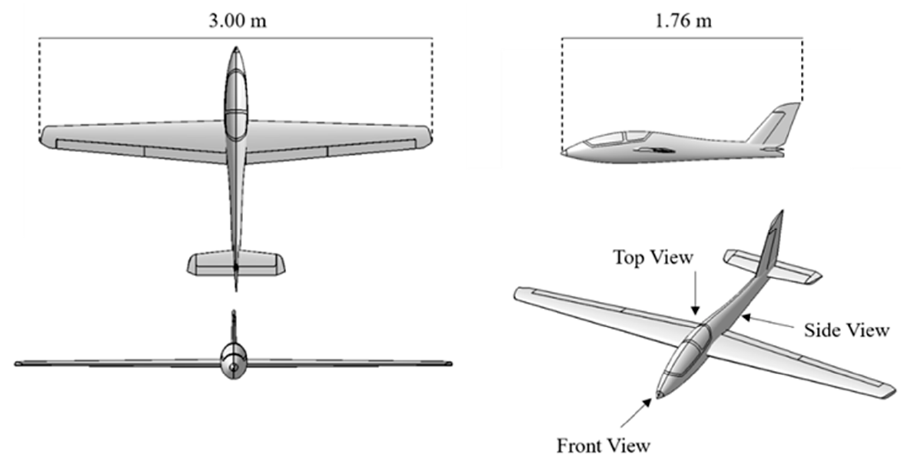
Figure 3. The glider Fox model.